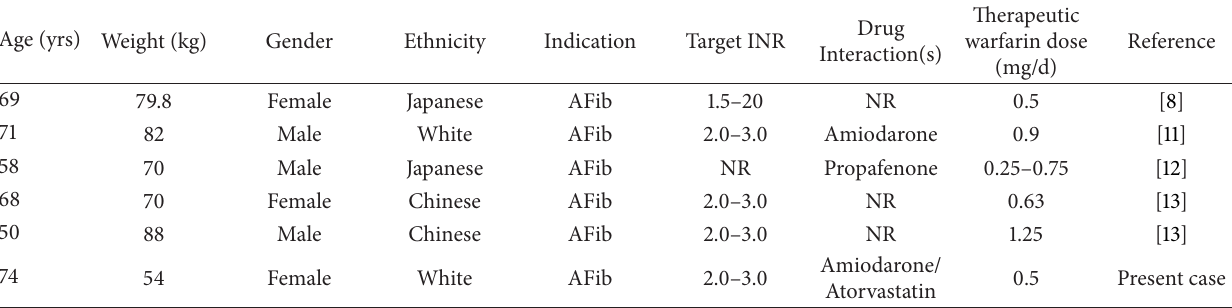
Table 1: Case reports of warfarin-dosing in patients with 𝐶𝑌𝑃2𝐶9 ∗ 3 ∗ 3 and VKORC1-1639 AA